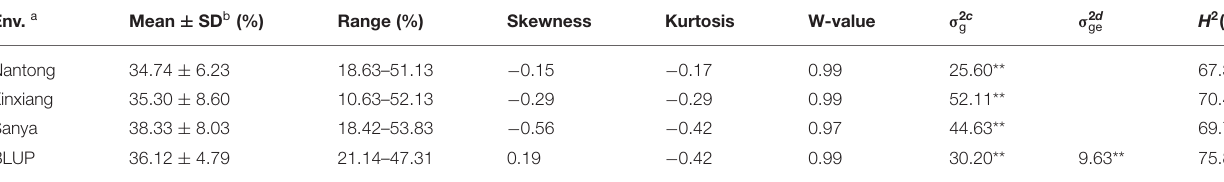
TABLE 1 | Phenotypic performance, variance component and heritability of KMC. Env. a Mean ± SD b (%) Range (%) Skewness Kurtosis